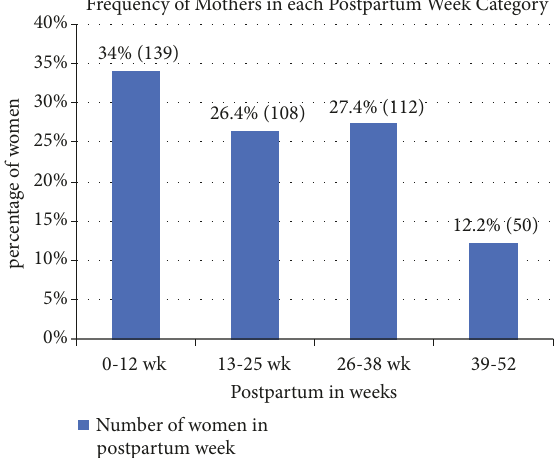
Figure 1: Percentage of women with respect to postpartum week in Tahtay Koraro, Ethiopia, April 2014.